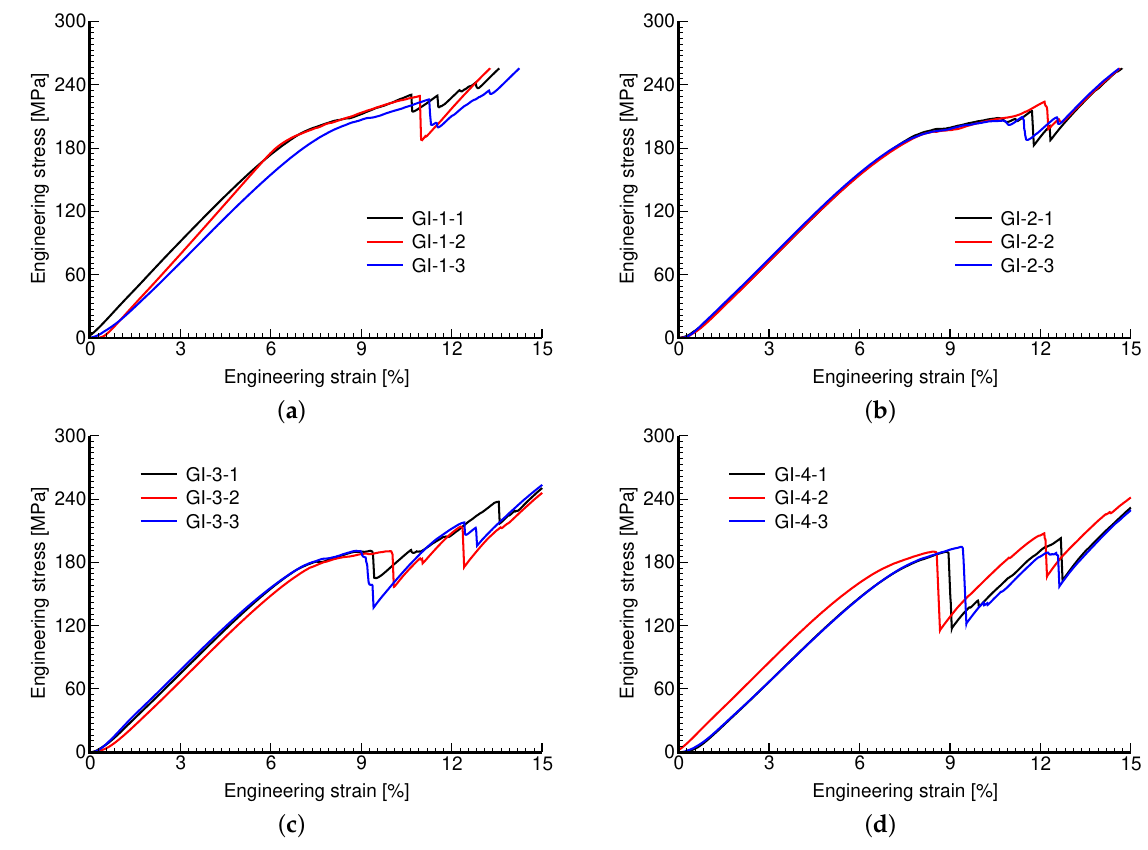
Figure 11. Engineering stress vs. engineering strain curves: ( a ) GI-1, ( b ) GI-2, ( c ) GI-3, ( d ) GI-4.